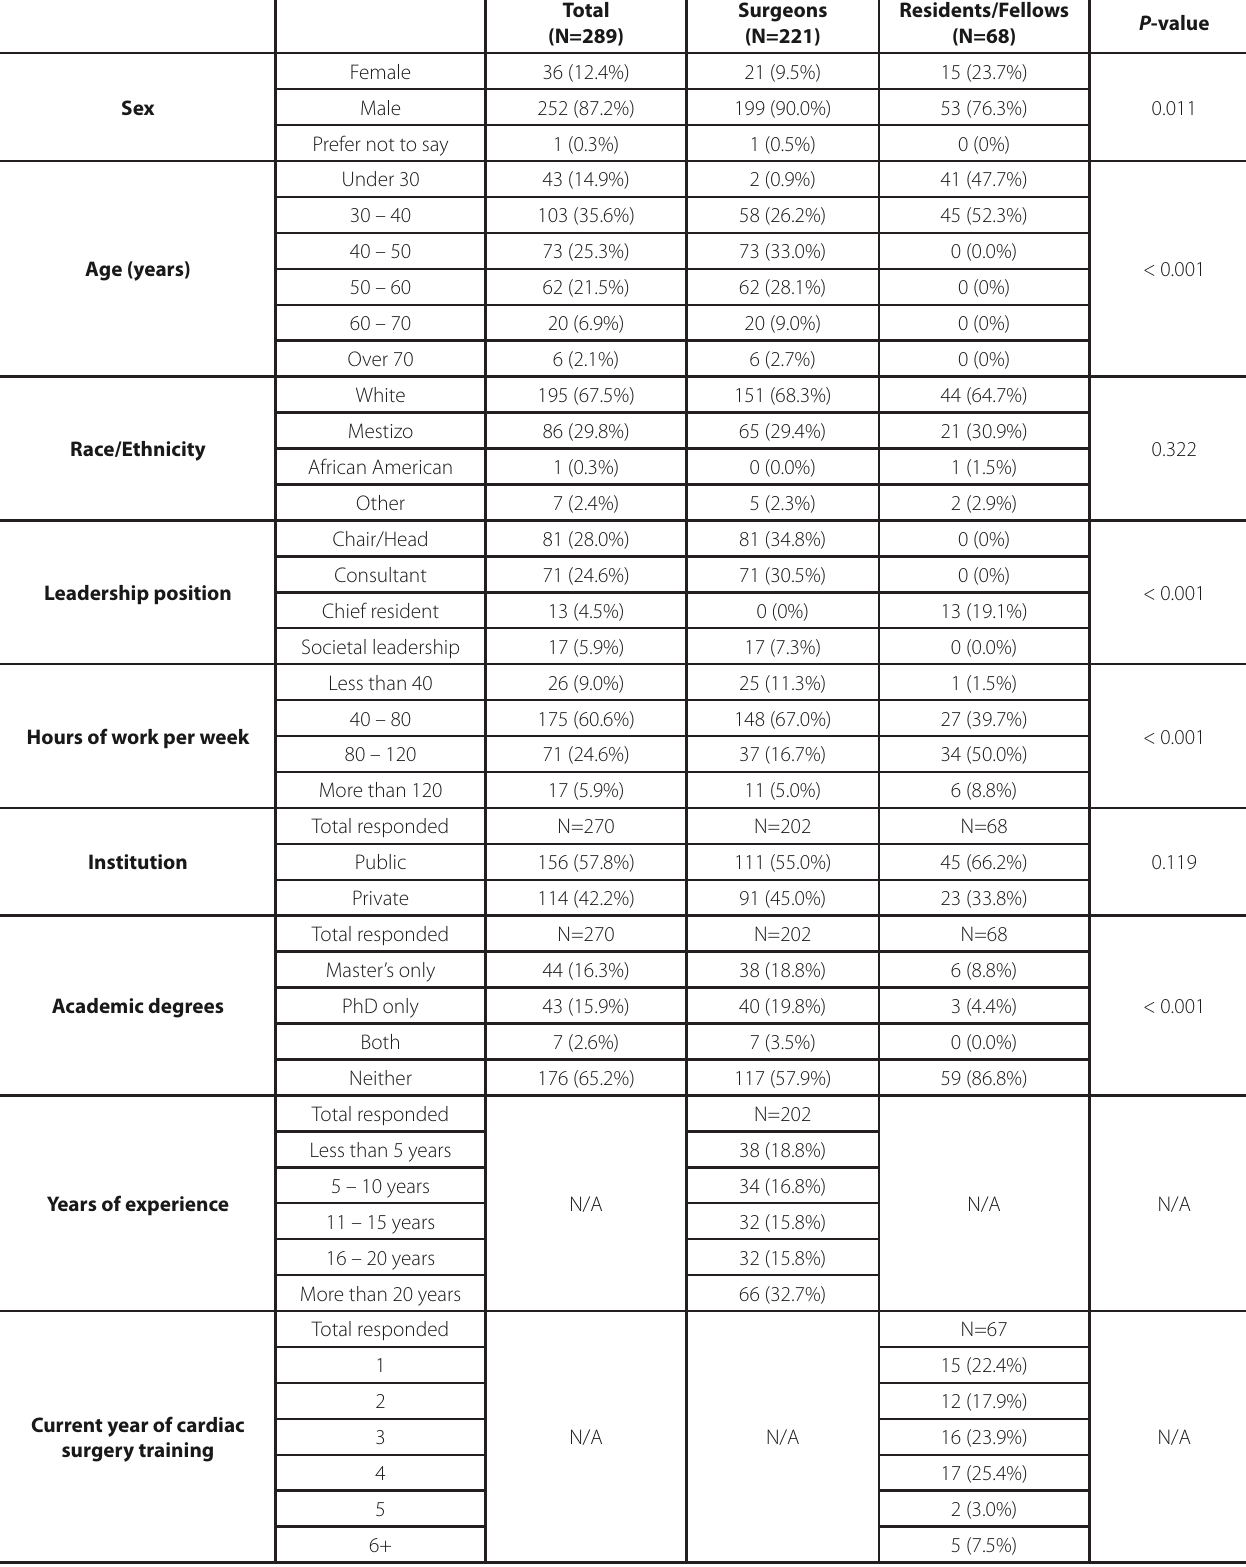
Table 1. Demographics of survey